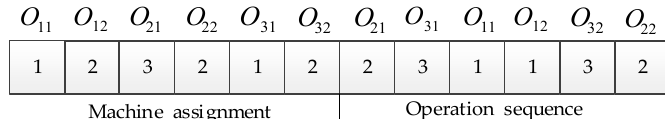
Figure 1. Scheduling solution denotation.